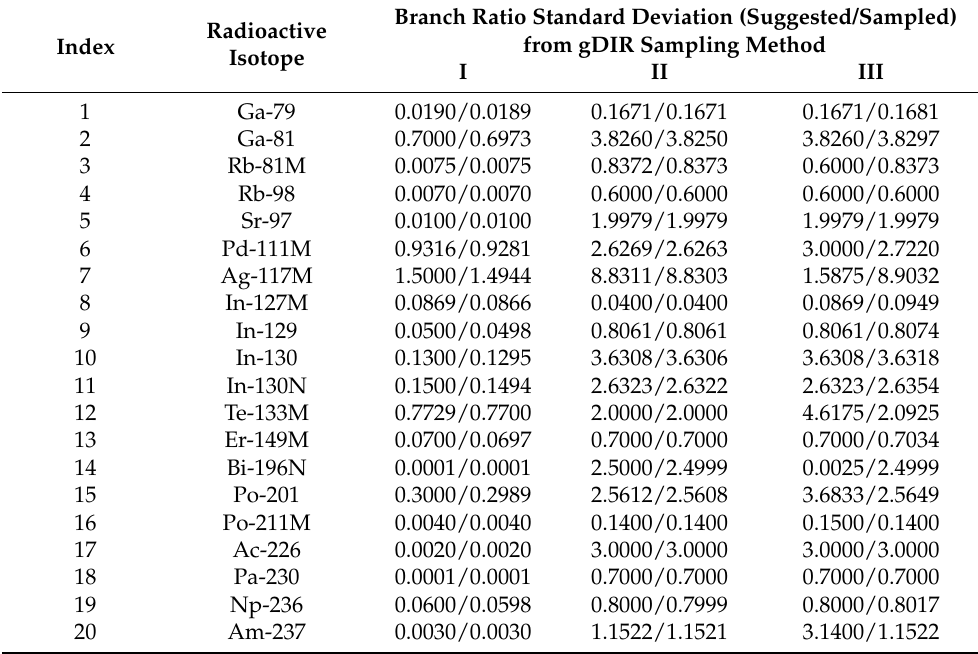
Table A5. gDIR sampling: branch ratio standard deviation estimation